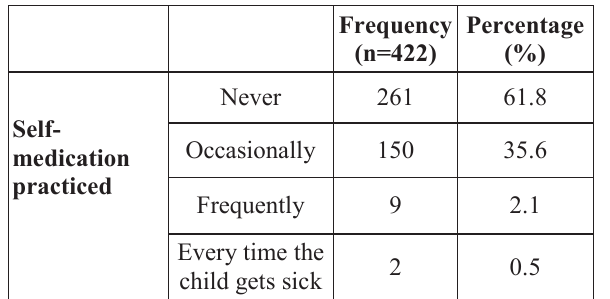
Table-2: Frequency of practicing self-medication